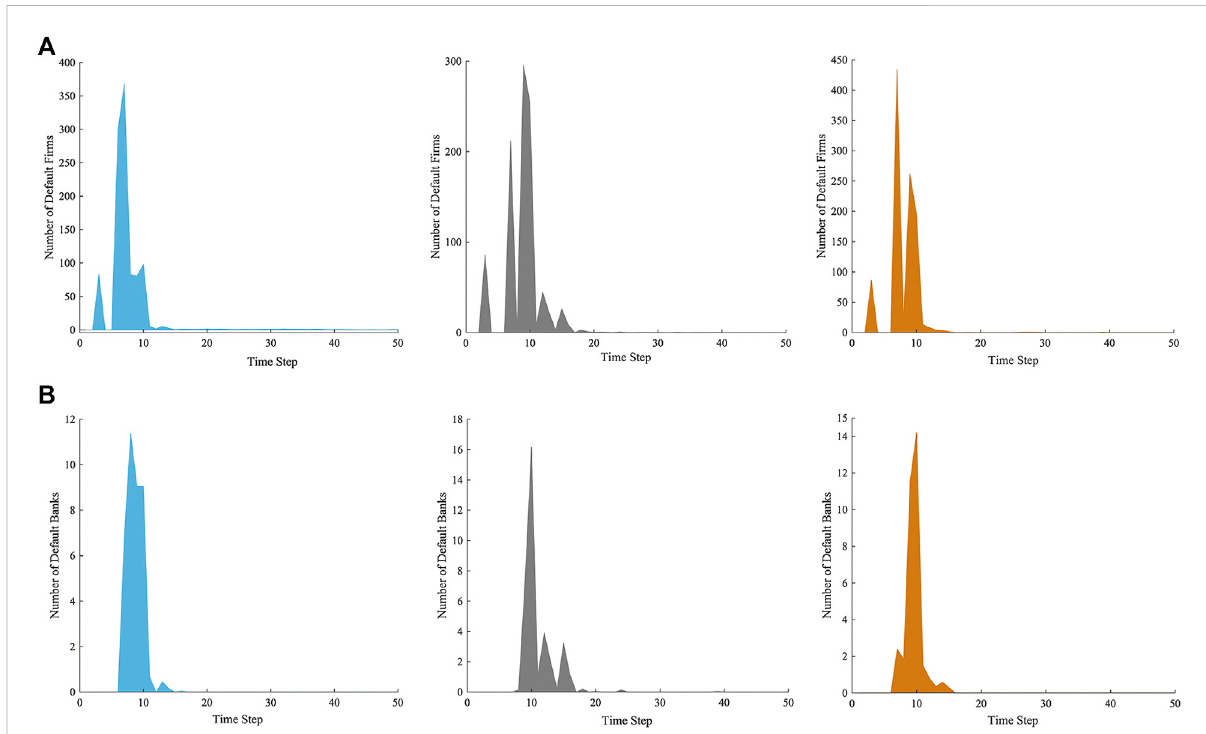
FIGURE 7 (A) The number of default fi rms and the time step of their default; (B) The number of default banks and the time step of their default. Blue, gray, and orange represent macroeconomic fl uctuations in upward, downward and random trends,